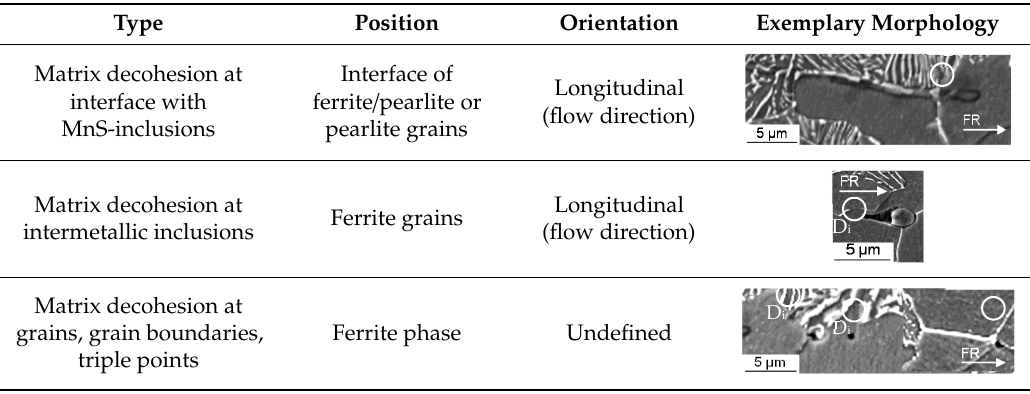
Figure 5. Material reaction under cyclic compression load conditions obtained longitudinal to, viz. in, the extrusion direction (l) after the load increase test (LIT).